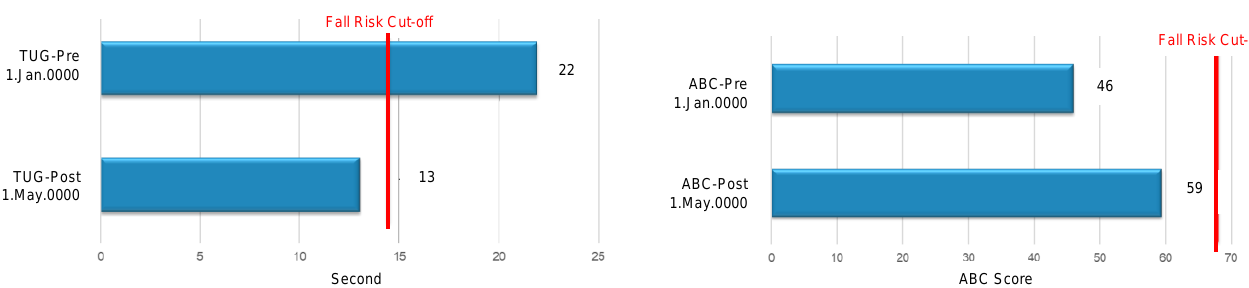
Average TUG Pre and Post Orthotics: Jon